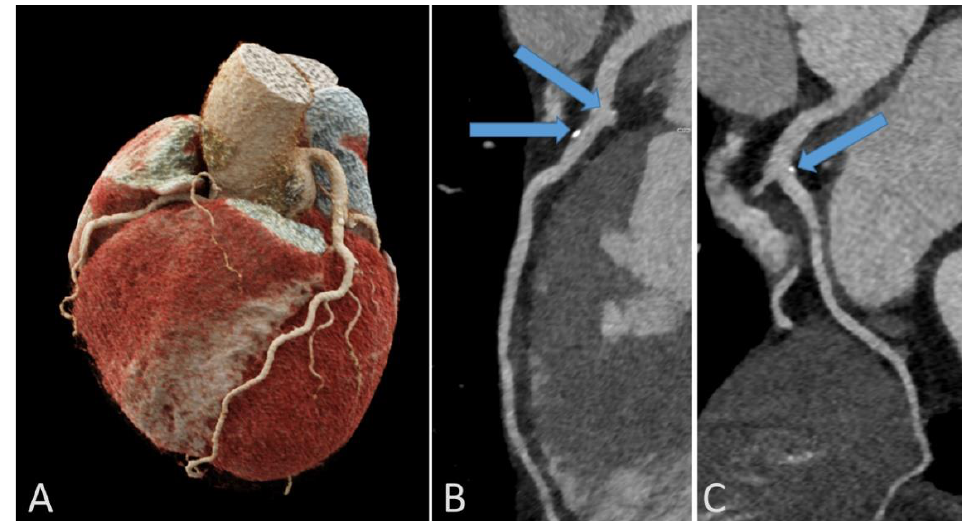
Figure 6. Representative example of coronary calcifications in a 56-year-old endurance athlete without risk factors who underwent coronary computed tomography for investigation of repolarization abnormalities on resting ECG. 3D reconstruction of the coronary artery tree ( A ). Calcific plaques in left anterior descending (arrows, B ) and circumflex (arrow, C ) coronary arteries.